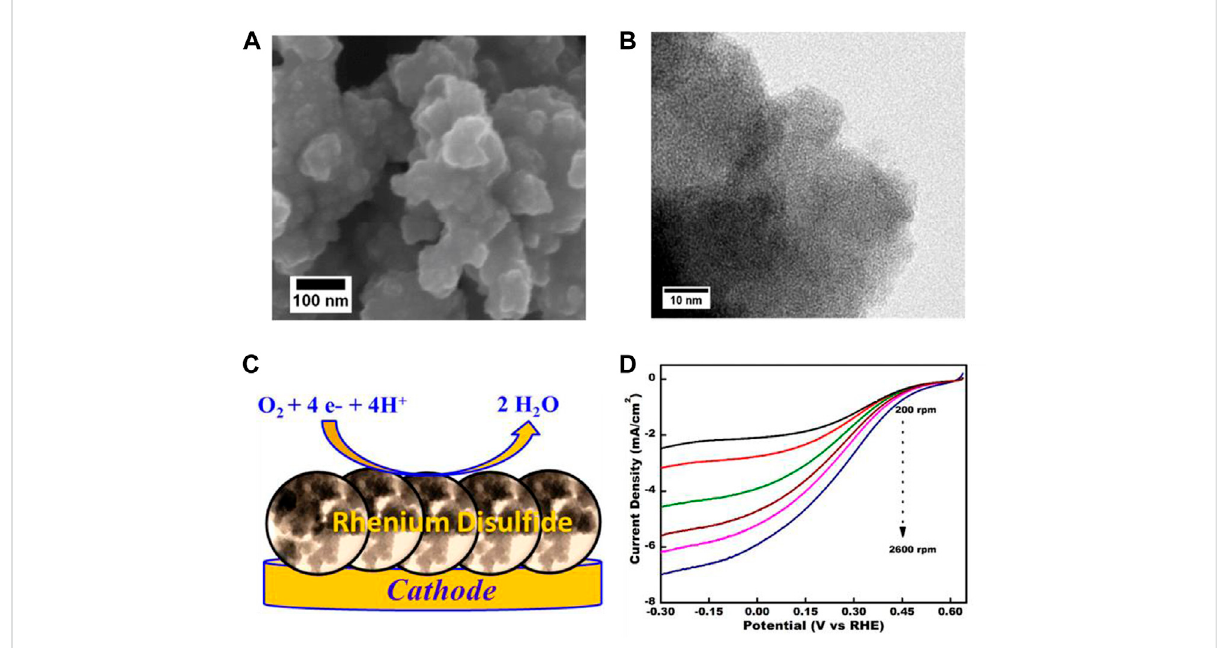
FIGURE 8 (A,B) FESEM and TEM images of the as-synthesizedReS theas-synthesizedcatalyst at differentrotation rates. Reproducedwith permission (Radhakrishnan etal., 2019).Copyright2019, American Chemical